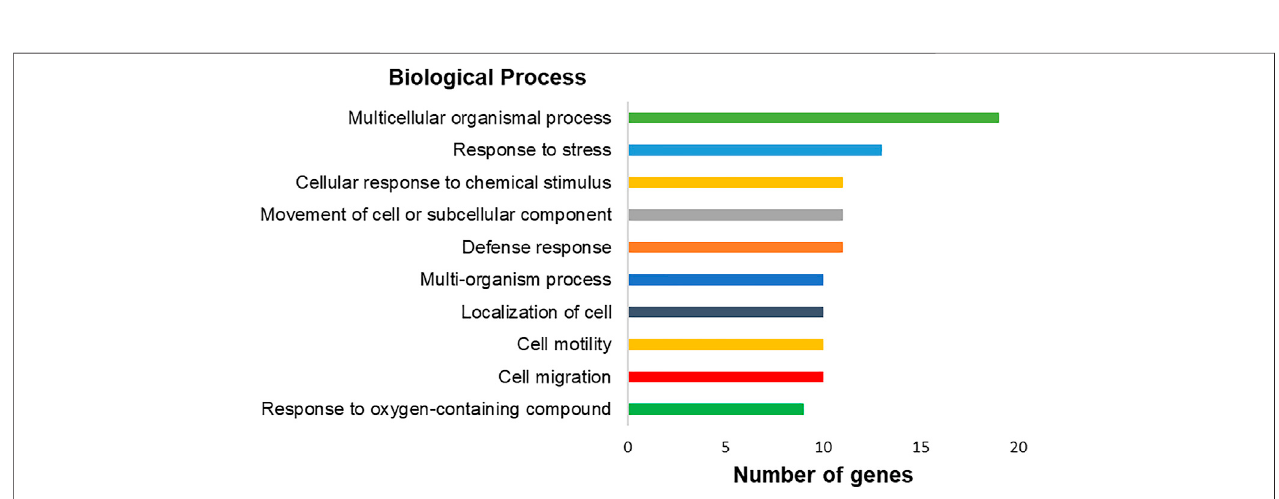
FIGURE8 | Graph representing the top-ranking biological processes ofdifferentially expressed genes inhPLF after immortalization processes and their respective number of genes found by transcriptome analysis. Biological processes based on gene ontology annotation, adopting p < 0.05.